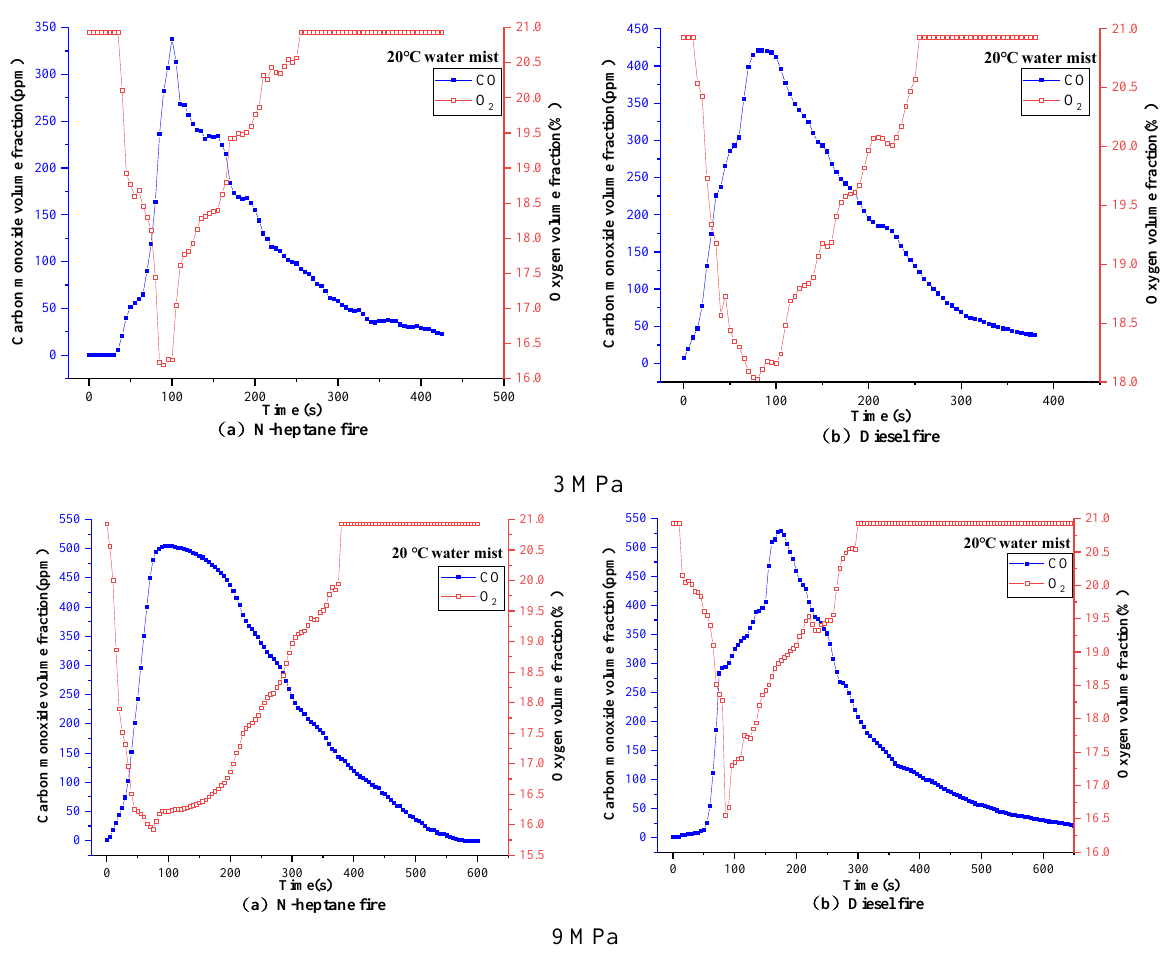
Figure 10. Change diagram of flue gas composition of diesel and n-heptane under the action of cold water mist at 3 MPa and 9 MPa.